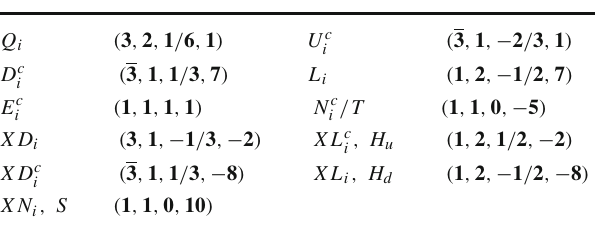
Table 2 The particles and their quantum numbers under the SU ( 3 ) C × SU ( 2 ) L × U ( 1 ) Y × U ( 1 ) (cid:3) gauge symmetry. Here, the correct U ( 1 )